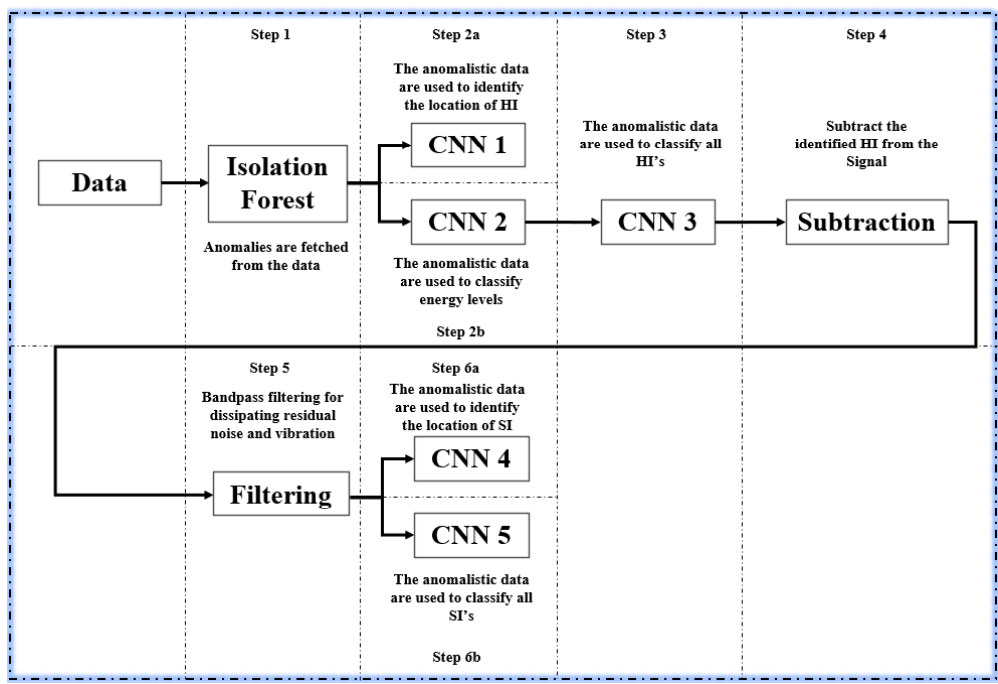
Figure 11. Final model structure.